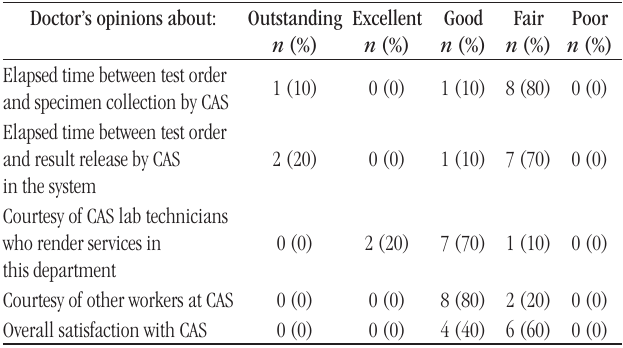
taBLE 3 − Time for releasing test results considered acceptable by most doctors in the study, found for tests of the AED and described in the literature